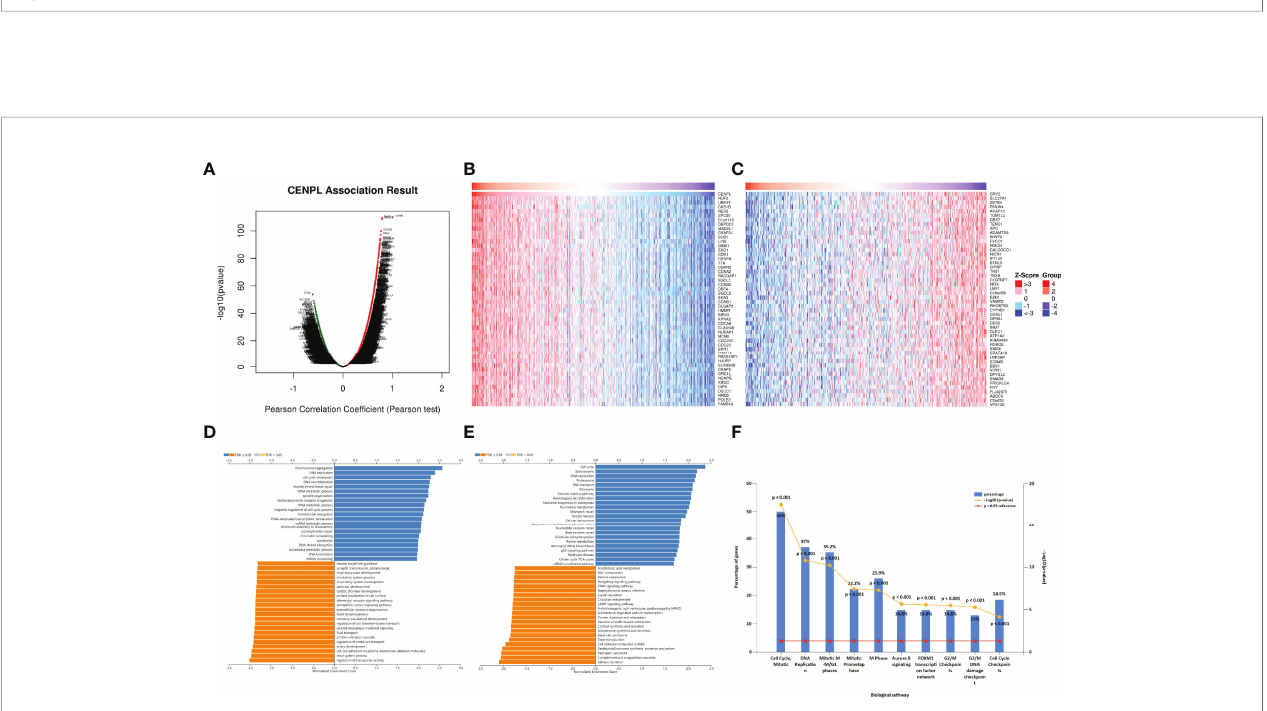
FIGURE 7 | The enrichment analysis of CENPL co-expression genes in LUAD. (A) The CENPL co-expression genes in LUAD. (B, C) The top 50 genes positively and negatively correlated to CENPL. (D, E) GO and KEGG analysis of CENPL co-expression genes in the LUAD cohort. (F) The biological pathway analysis of CENPL co-expression genes in the LUAD cohort.